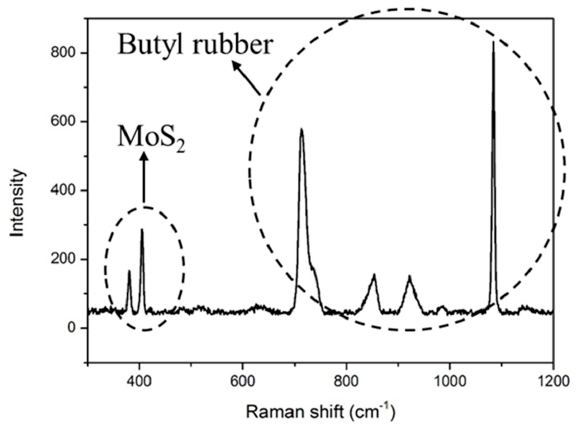
Figure 7. Typical Raman peaks for MoS 2 -butyl nanocomposites.